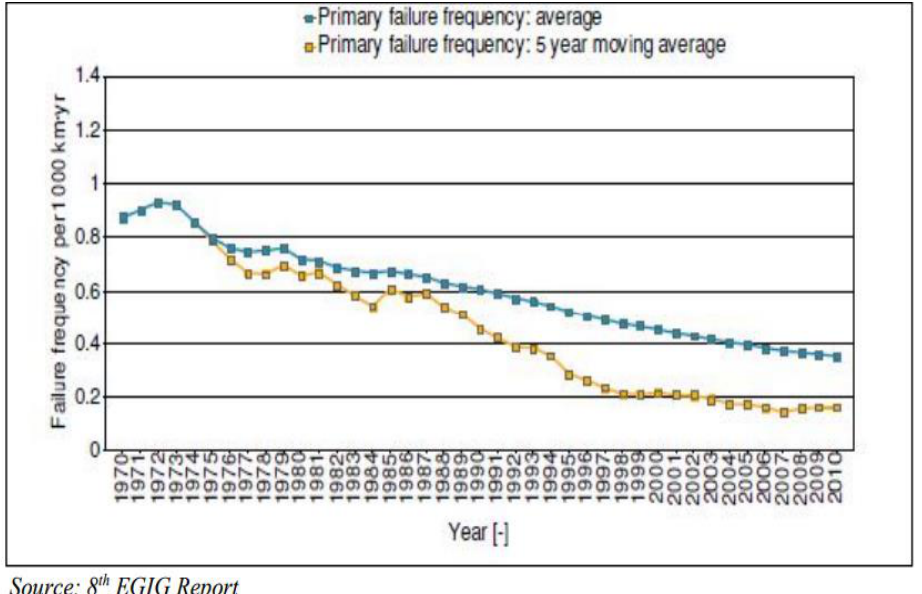
Figure 3. Evolution of primary failure frequencies.